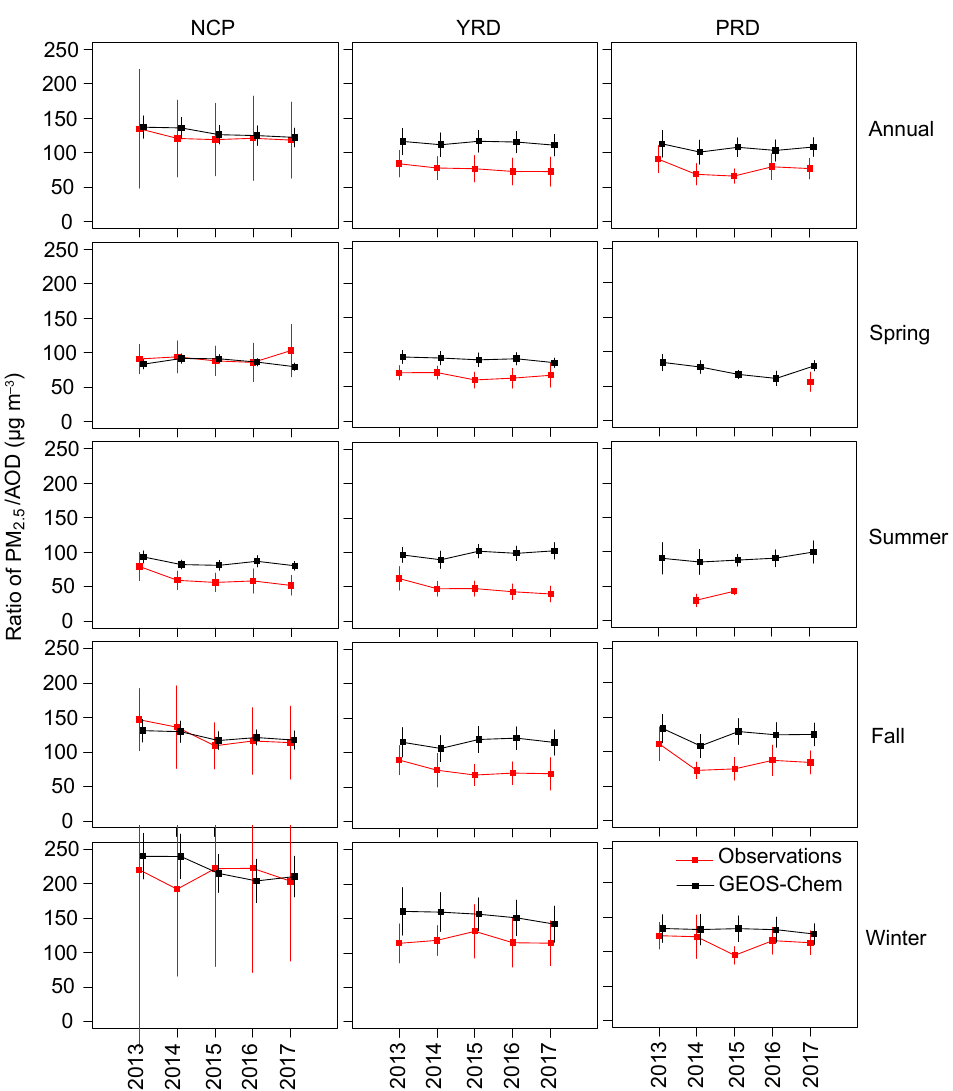
Figure 2. Observed (red lines) and GEOS-Chem simulated (black lines) ratio of PM 2.5 /AOD ( η ) in NCP, YRD and PRD in 2013–2017. The bars are standard deviations.